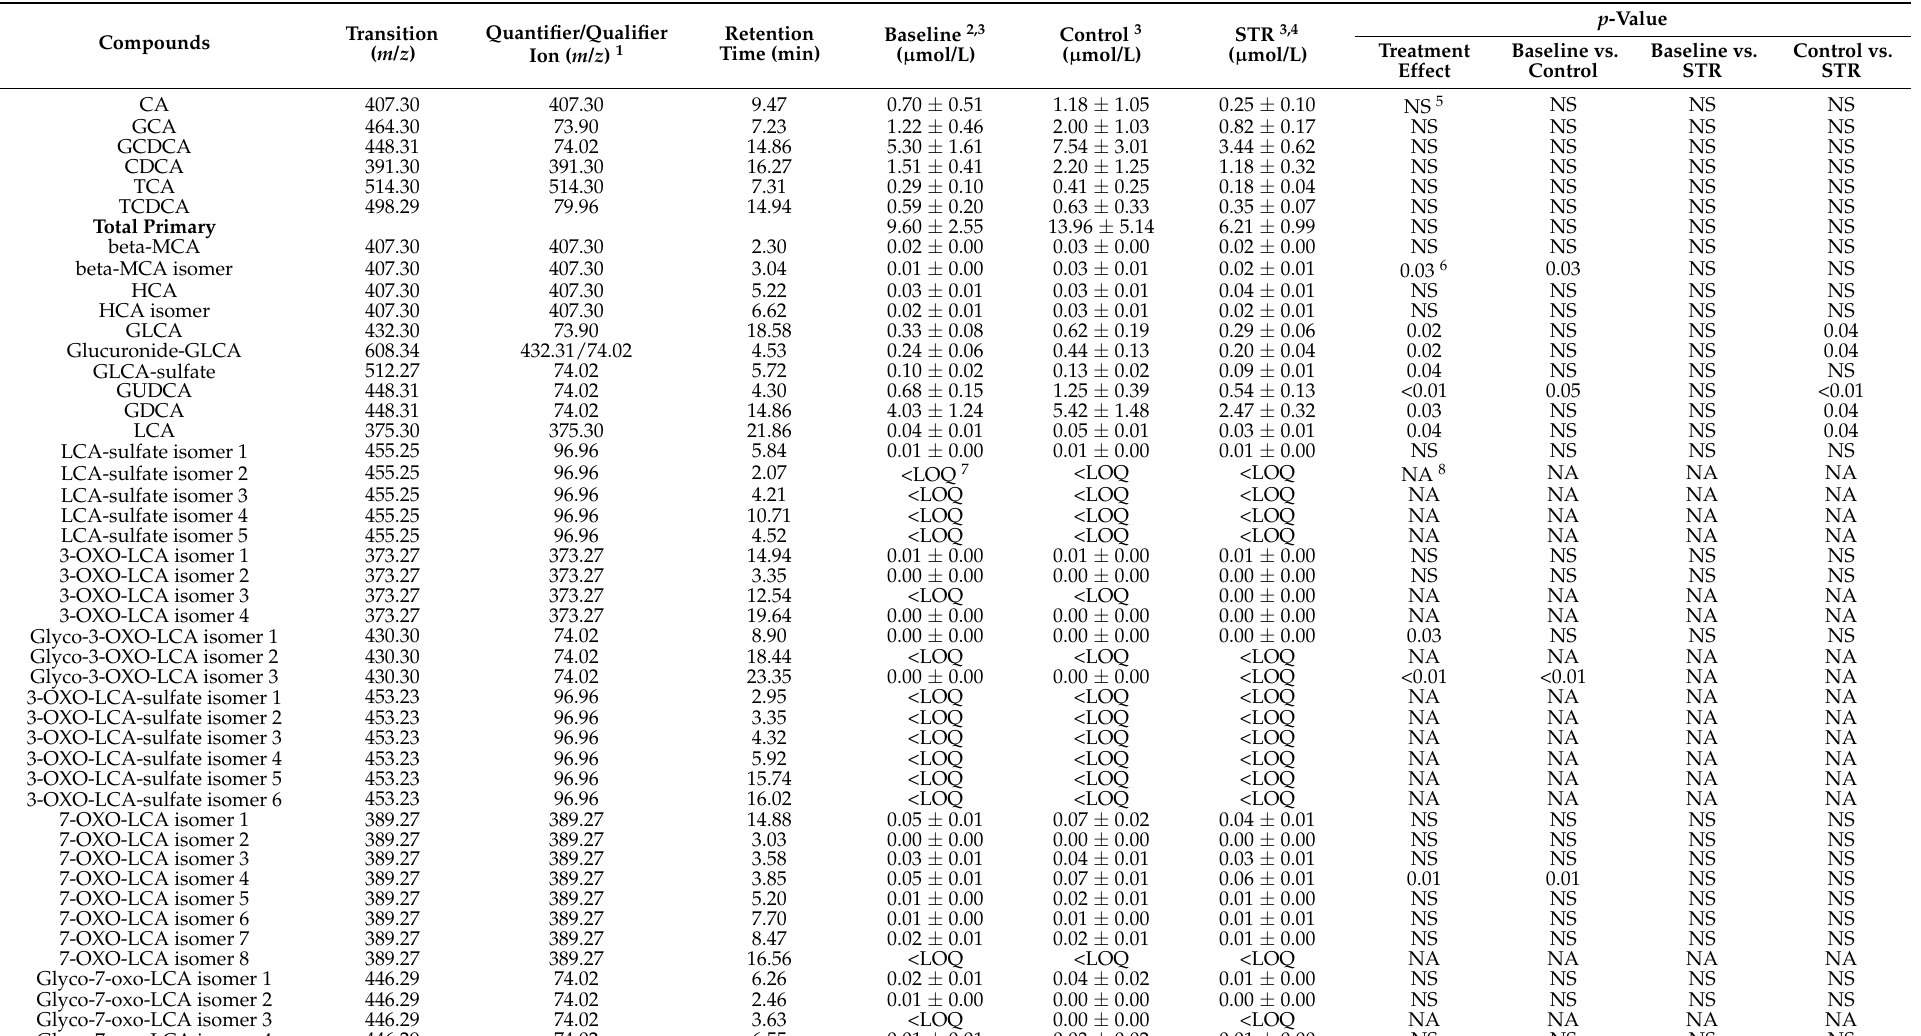
Table 3. Bile acids (BAs) concentrations in fasting human plasma samples after 4-week strawberry or control beverage intake.